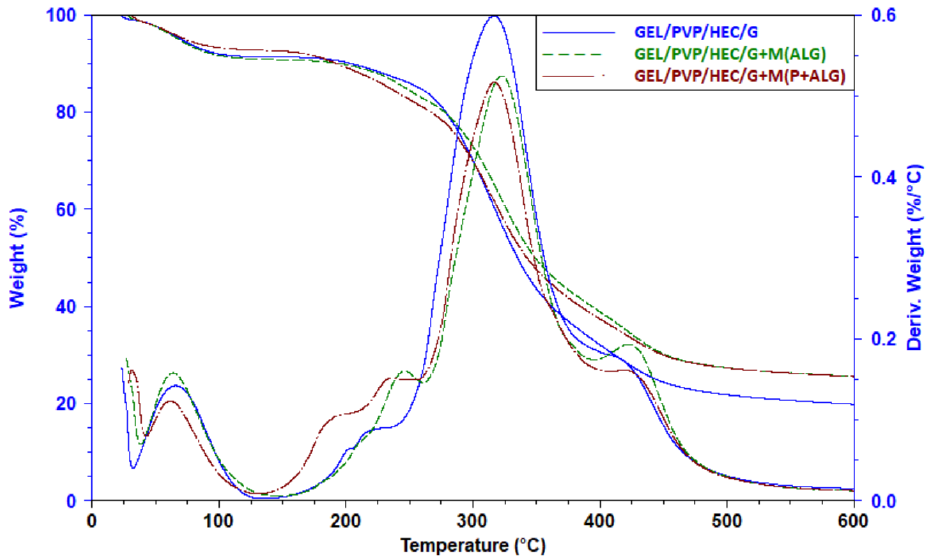
Figure 7. Thermogravimetric (TG) and derivative thermogravimetric (DTG) curves of GEL/PVP/HEC/G matrices with and without microparticles. Table 4. The temperature of the beginning of the sample decomposition (T 0 ), the temperature at the maximal rate of the process (T max ), the weight loss in the main stage ( ∆ m), and the char residue at 600 ◦ C for the prepared